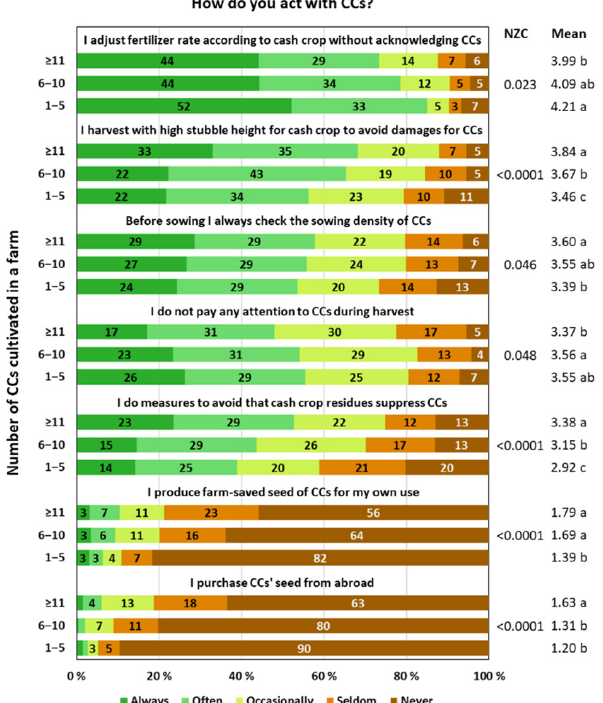
Figure 11. The distribution of farmers’ answers (N = 1130) depending on the number of cultivated cover crops (CCs) on the farm (NZC, nonzero correlation).